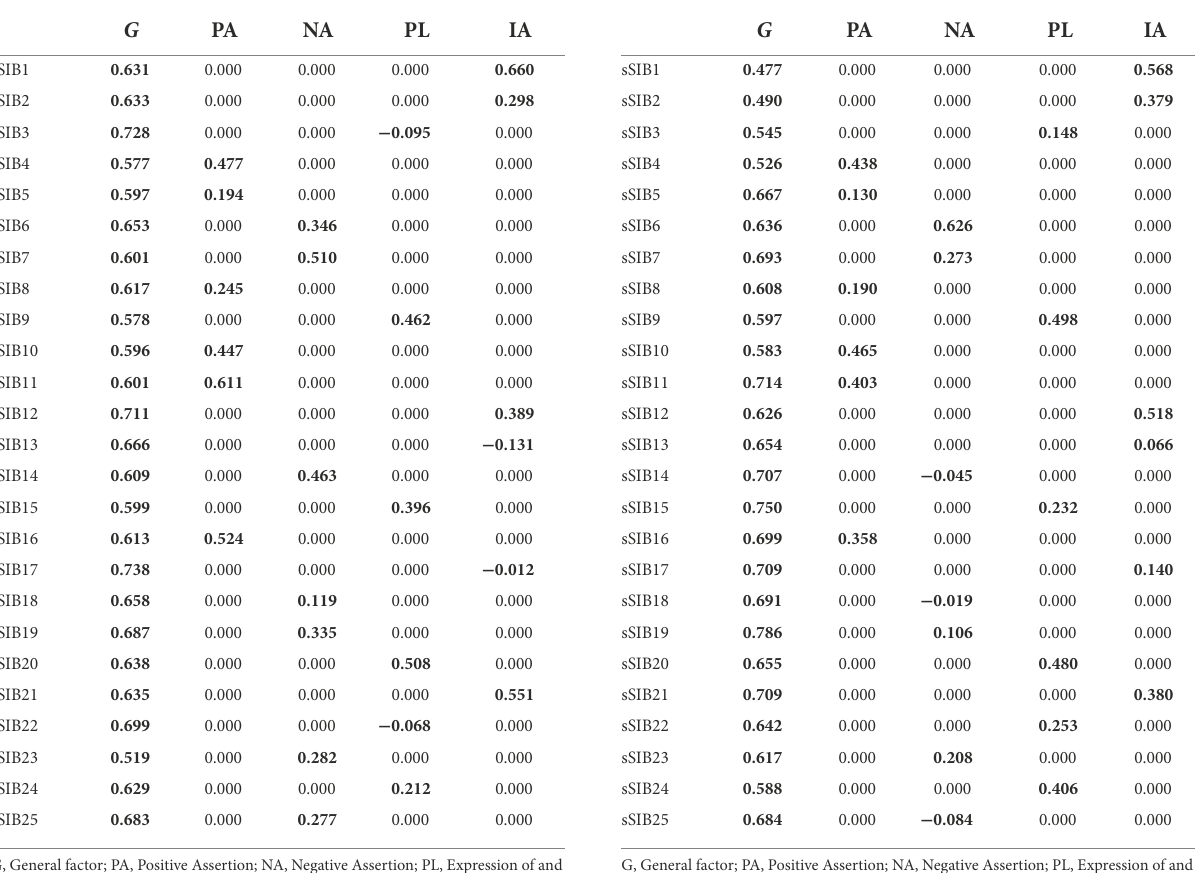
TABLE 2 Bifactor confirmatory IRT model – factor loadings for s-SIB